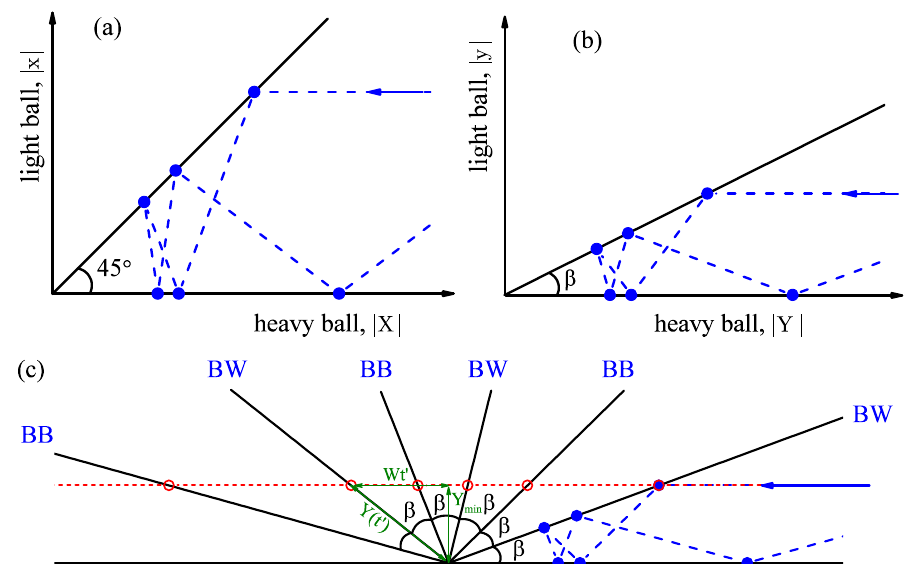
Figure 6. The trajectory in different phase spaces, ( a ) original coordinates 0 ≤ | x | ≤ | X | , ( b ) variables of billiard in a wedge, 0 ≤ | y | ≤ | Y | tan β , ( c ) unfolded trajectory. The parameters are b = 2 and N = 1 and correspond to time-dependent data shown in Figure